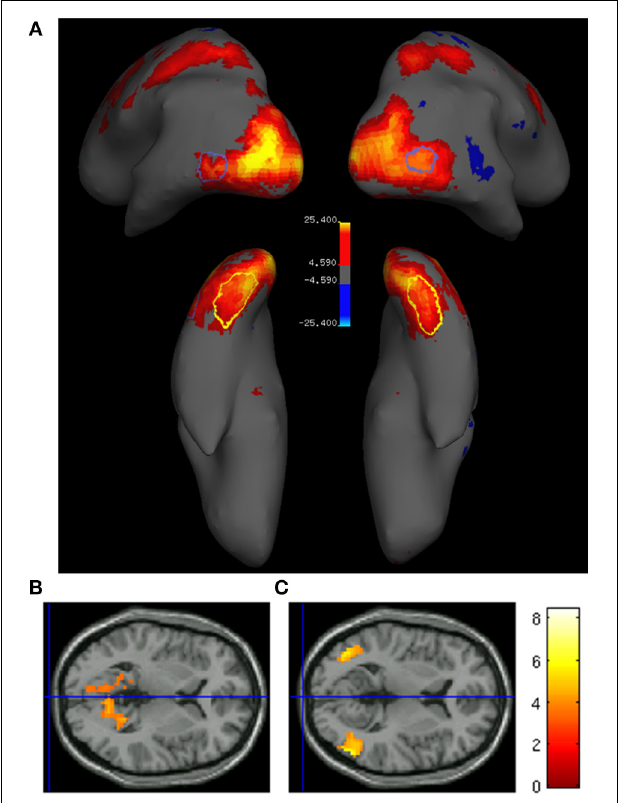
FIGURE 4 | (A) Task associated activity (task > baseline; p < 0 . 05 FWE) in a single subject superimposed onto the inflated brain. Yellow/red areas indicate a significantly higher activation for task trials, while blue areas indicate a significantly higher activation for baseline trials. Closed yellow and blue contours indicate the locations of retinotopically mapped V4 and V5, respectively. Bottom row: Transverse sections of the cortex showing group level activity ( n = 16) superimposed onto the canonical brain, for (B) color > motion (MNI Z = 3, and (C) motion > color (MNI Z = 6; p < 0 . 001).